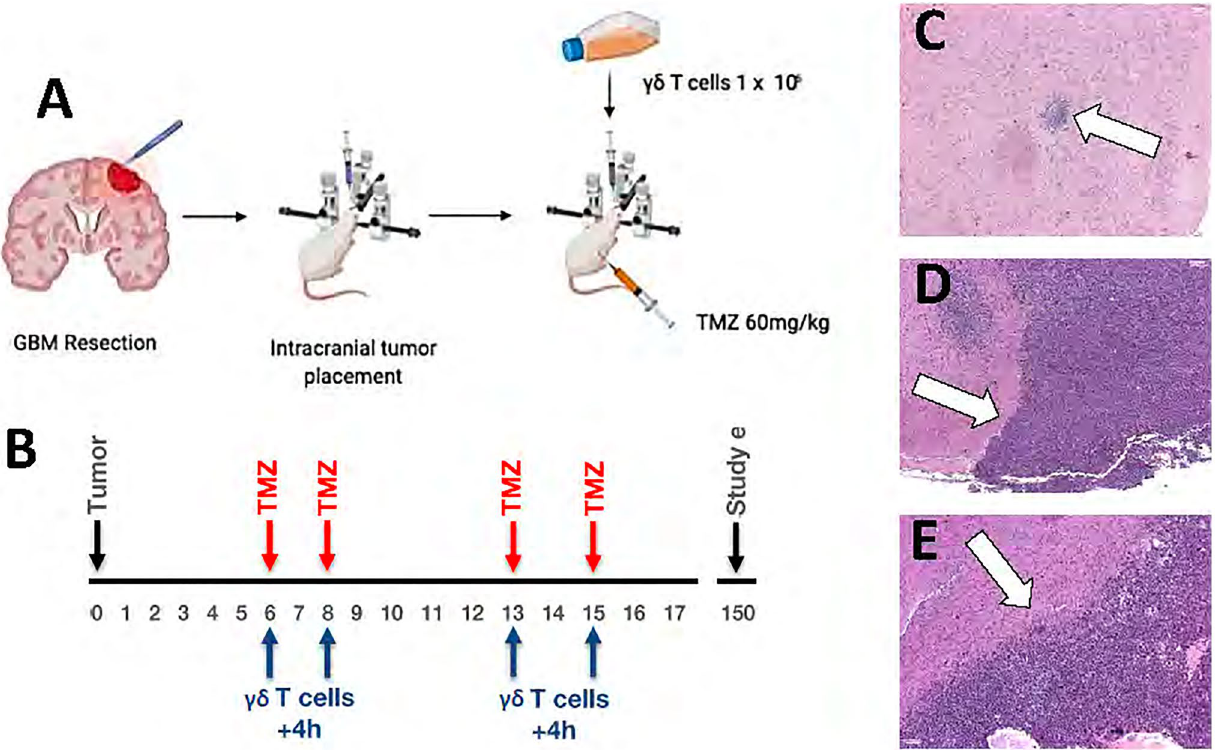
Figure 2. Study protocol. ( A ) Single-cell disaggregated PDX tumors are prepared from primary and TMZ- resistant GBM and were injected into the left cerebral hemisphere using a stereotactic frame. Mice receiving MGMT-modified γδ T cells received intracranial injections using the identical stereotactic coordinates. MGMT was delivered intraperitoneally Adapted from “General Figures”, by BioRender.com (2021). Retrieved from https:// app. biore nder. com/ biore nder- templ ates. ( B ) Tumor-bearing mice received two cycles intraperitoneal (IP) 60 mg/kg TMZ and 1 × 10 6 MGMT-modified γδ T cells concurrently spaced 48 h apart and repeated one week later. Mice treated with single-agent TMZ or γδ T cells maintained the same schedule for the respective agent. ( D ) Hematoxylin and Eosin (H&E) staining of digital light microscopic image (4 ×) of an untreated JX12P PDX tumor (white arrows) at post-injection day + 6 and ( D ) the characteristic rapid growth of the tumor at day + 16. Image ( E ) shows a 16-day tumor after four cycles of TMZ chemotherapy. Note that although significant damage to the tumor has occurred several viable and proliferating colonies